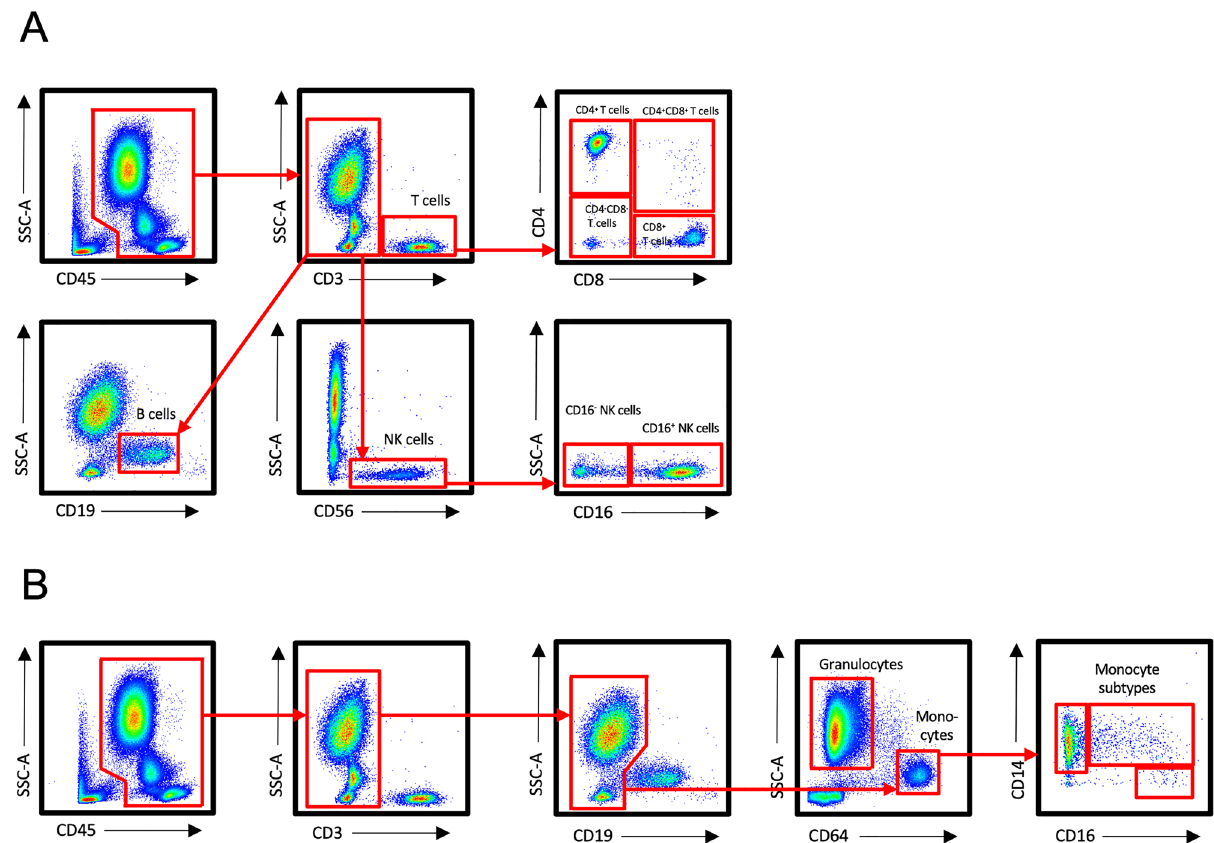
Figure 1. Flow cytometry gating strategy of immune cells studied. ( A ) staining panel 1, ( B ) staining panel